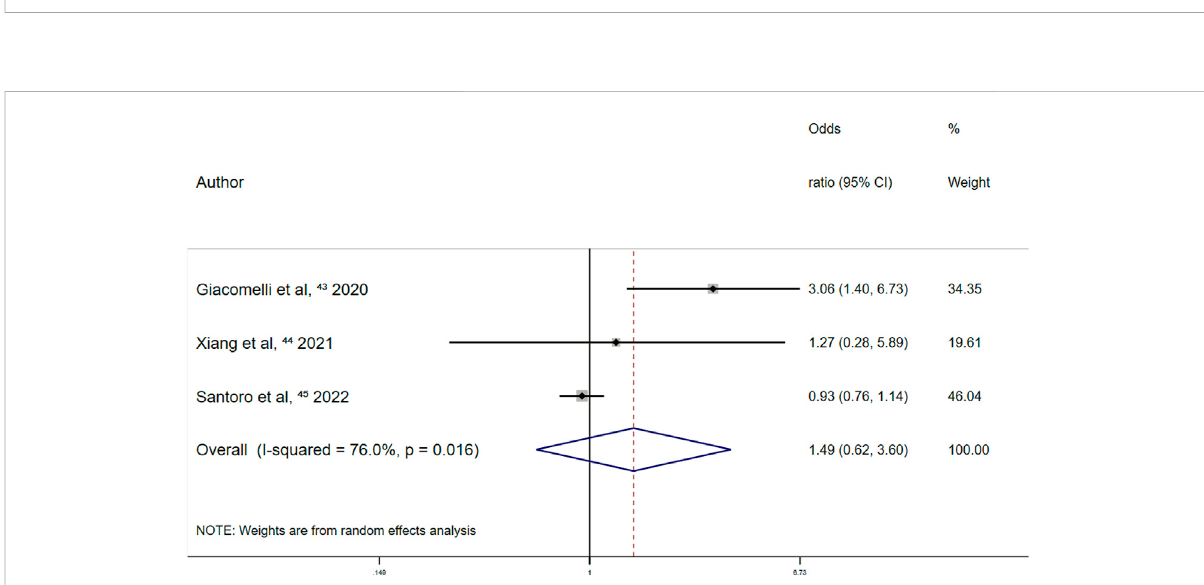
FIGURE 3 Summary odds ratio of all-cause mortality for other antiplatelet drugs use in prospective cohort